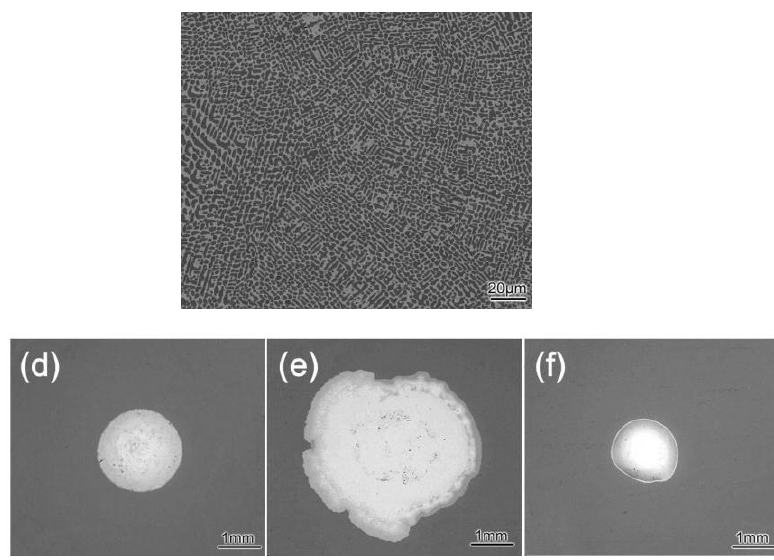
Fig. 10 - Top: Microstructure of a Cu-Fe alloy with 50wt%Cu. Iron is dark, copper is grey. Bottom: top-view of areas Figure 10. Top : Microstructure of a Cu-Fe alloy with 50 wt% Cu. Iron is dark, copper is wetted by Sn on Cu, θ=25 °(d), 50Cu- 50Fe, θ=5 ° (e) and Fe θ=47 °(f) [18]. grey. Bottom : top-view of areas wetted by Sn on Cu, θ = 25° ( d ), 50Cu-50Fe, θ = 5° ( e ) and Fe θ = 47° ( f )